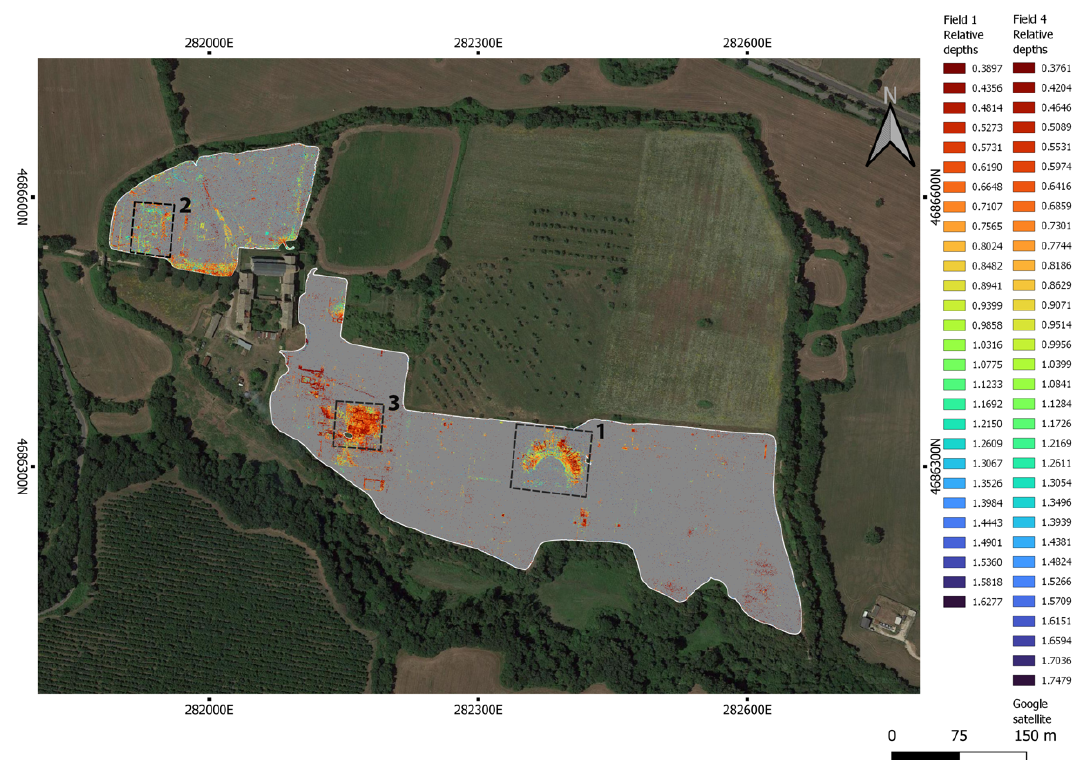
Figure 4. Falerii Novi, “merged signal peaks map” of fields 1 (time-slices from 8–9 to 35–36 ns) and 4 (time-slices from 8–9 to 39–40 ns), and indication of case study areas: (1) the theatre; (2) the “ Capitolium ”; (3) the bath complex (aerial photograph from Google Earth; image by M. Serpetti).